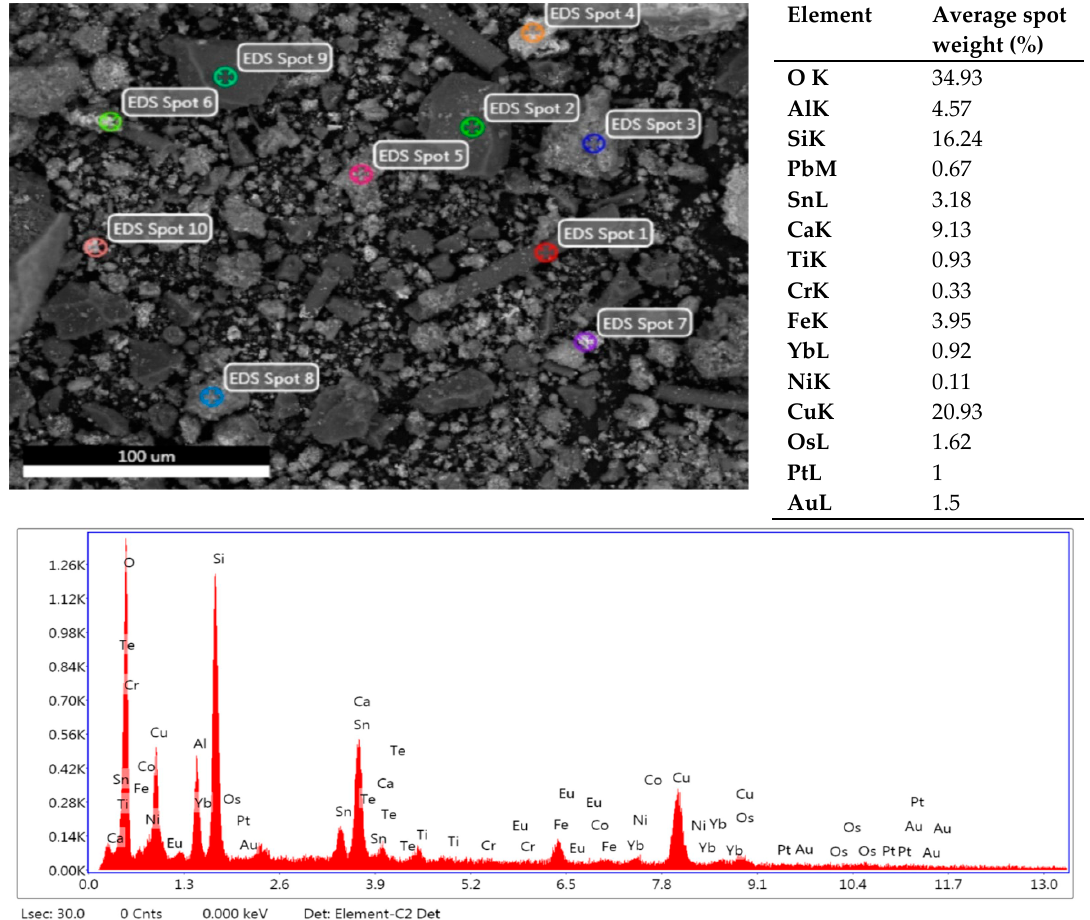
Figure 3. The scanning electron microscopy (SEM-EDX) of PCBs powder sample.